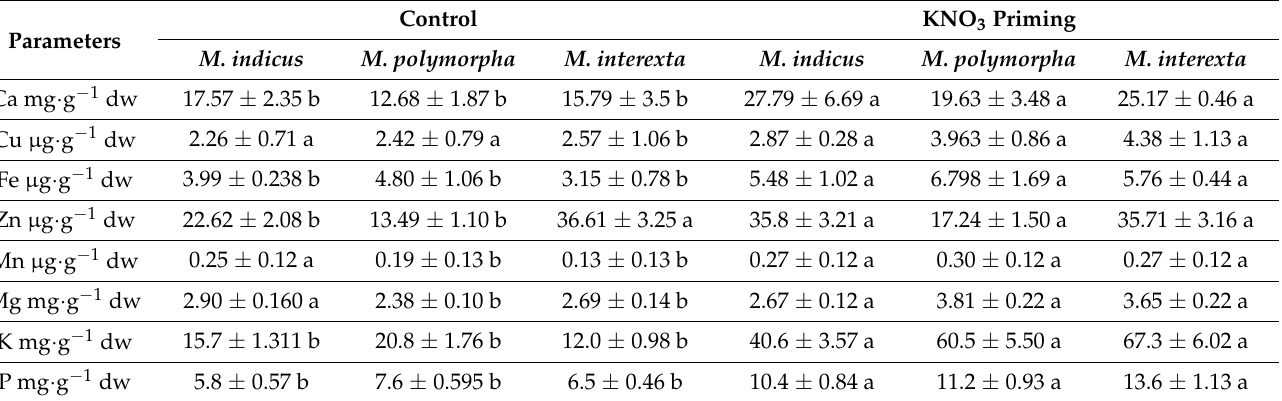
Table 1. Effect of KNO 3 priming on nutriments content of three species of Medicago sprouts. Values are represented by mean ± standard deviation of at least three independent replicates. Means marked by different letters are significantly different than control at p < 0.05.